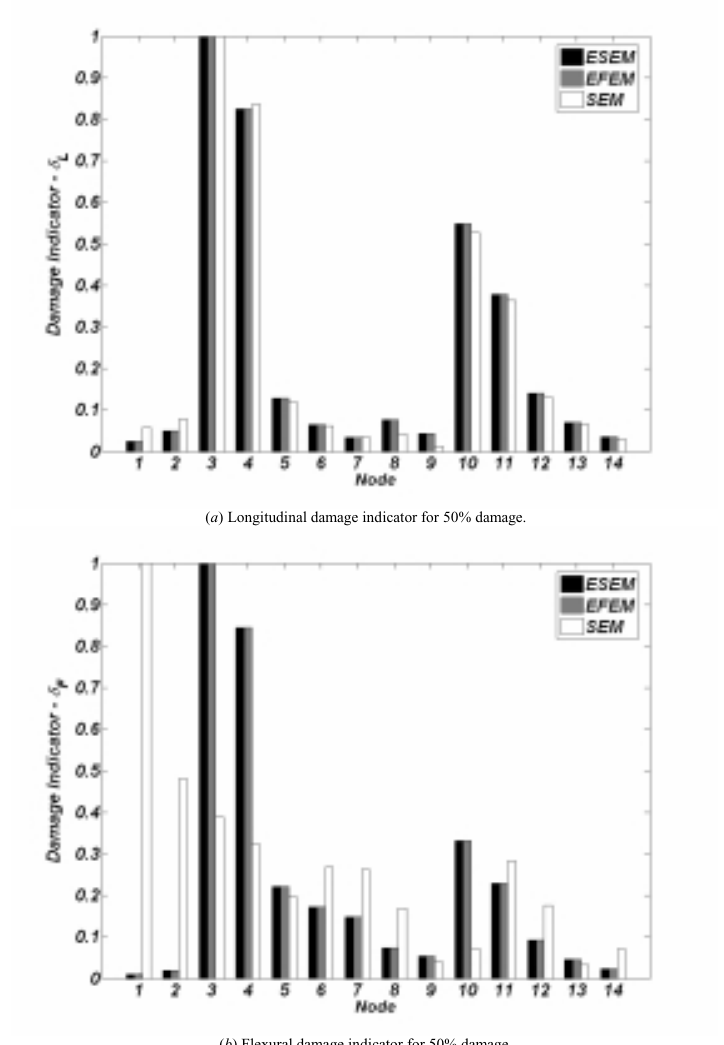
Fig. 10. Longitudinal and flexural damage indicator by ESEM, SEM and EFEM for beams angle connection coupling with damage level of 50% change in the loss factor. and dimension problem dependent. Numerical results clearly indicate that the methods can be used to detect and localize the damage regions, but it must be admitted that this study represents only a simulation test of the concepts. Further experimental investigations are needed and they are currently under